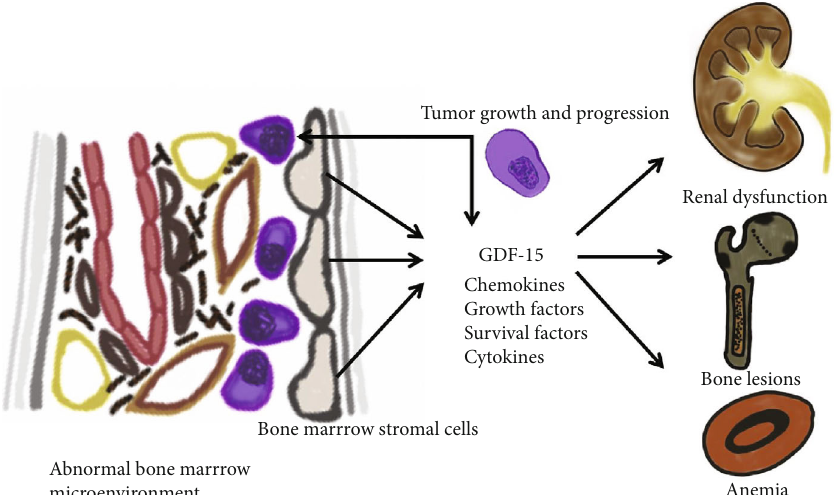
Figure 5: The proposed graphical representation of the bone marrow environment in multiple myeloma and end-organ involvement: abnormal bone marrow stromal cells release growth factors, cytokines, and survival factors (including GDF-15) following interactions with malignant plasma cells, which leads to uncontrolled tumor growth and progression. GDF-15 is associated with the development of the cardinal features of myeloma (anemia, renal impairment, and bone lesions), and it may be a mediator of pathways related to the development and progression of these